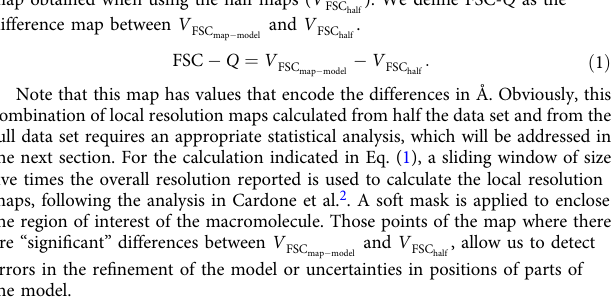
implement an algorithm to evaluate the quality of the fi tting of the atomic model into the density map following a similar strategy, but locally. Our algorithm follows the general principle of making a comparison between the full data set and the map generated from the atomic model, now using the local ; note that the values of this volume are measured in resolution map ( V FSC map (cid:1) model Å). However, the key novelty is that we then compare it with the local resolution map obtained when using the half maps ( V FSC ). We de fi ne FSC- Q as the half difference map between V FSC and V FSC map (cid:1) model half